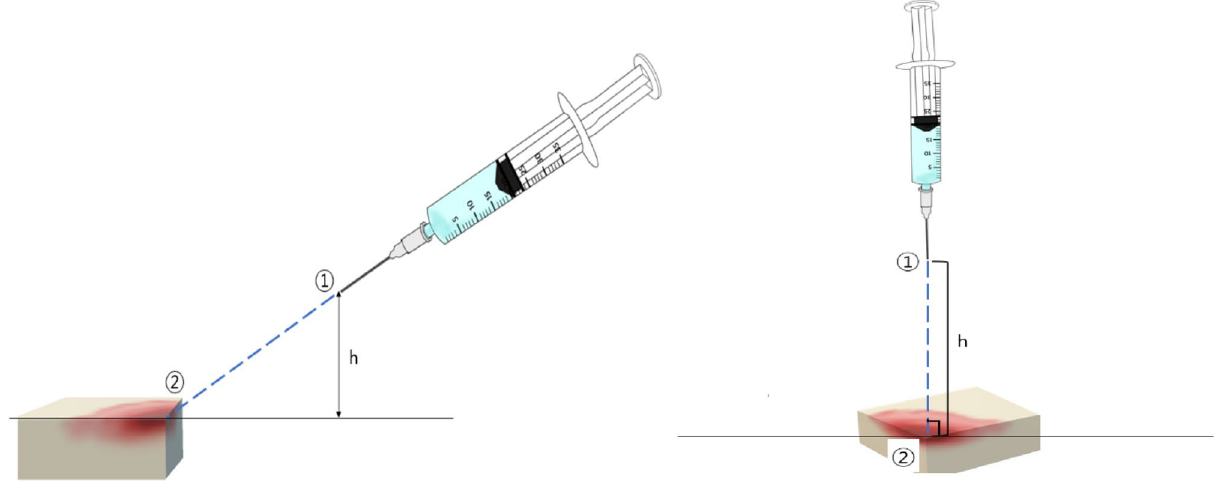
Figure 5. Structure of analyze